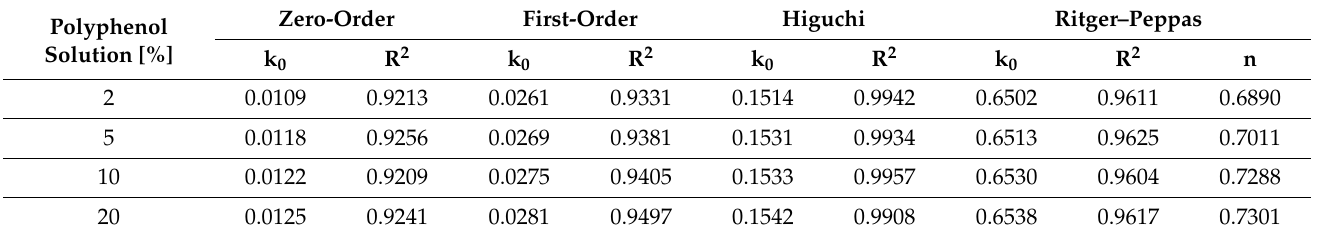
Figure 5. Tannic acid release from chitosan/glyoxal hydrogels curves of Higuchi square root model (n = 3). Table 2. Kinetic parameters of tannic acid release from chitosan/glyoxal hydrogels.